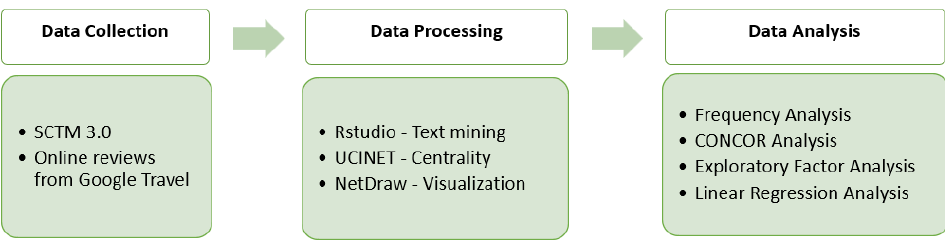
Figure 1. Research procedures.